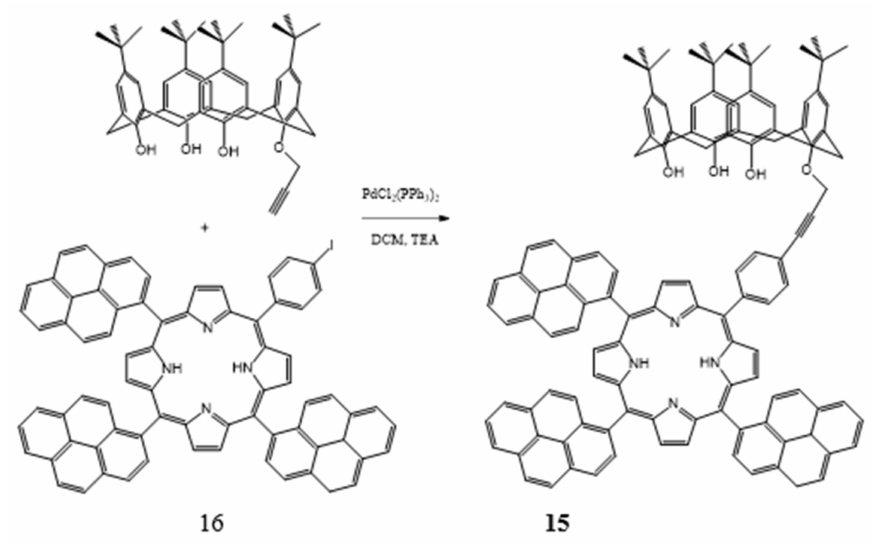
Scheme 5. Synthesis of the calix[4]arene-porphyrin 15 . The procedure of synthesis of the tetra-formyl derivative of thiacalix[4]arene in the 1,3-alternate conformation is presented in Scheme 6. Bromation of commercially available tetrahydroxy-thiacalix[4]arene ( 18 ) by N -bromosuccinimide in acetone was used to synthesize tetrabromo-derivative ( 19 ), which was then turned into the